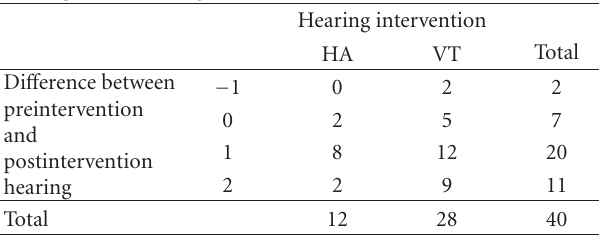
Table 1: Comparing treatment outcomes by way of di ff erences in pre- and post-intervention hearing.